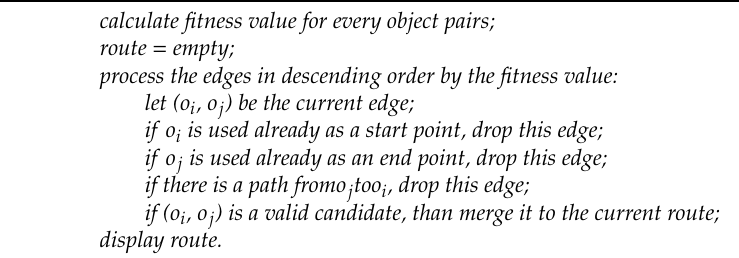
Table 5. Heuristic algorithm for route